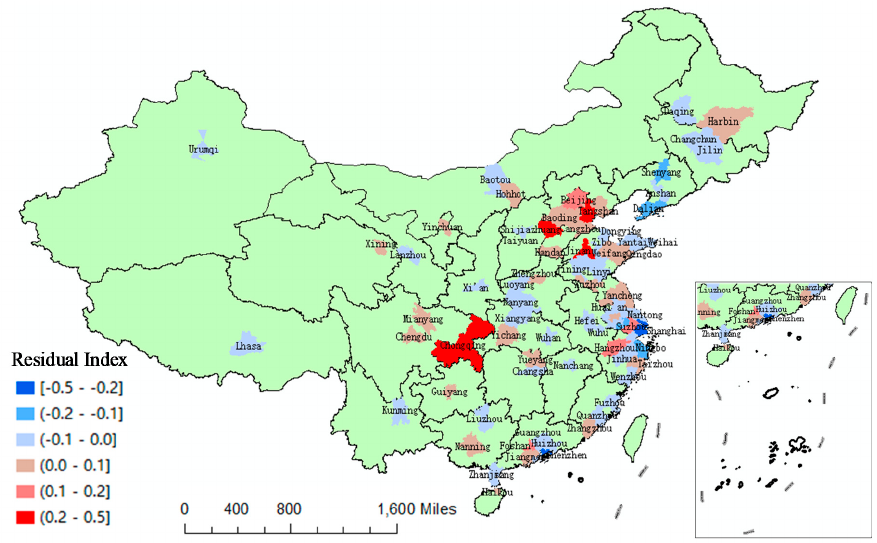
Figure 8. The statistical result of the relative residuals by using the OSM road network density.